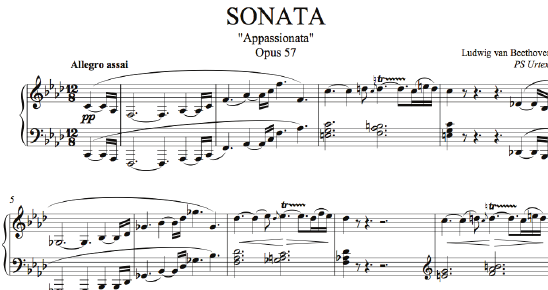
Figure 1 . Beethoven, Sonata op. 57. Appassionata, first movement: first theme (bars 1-9)